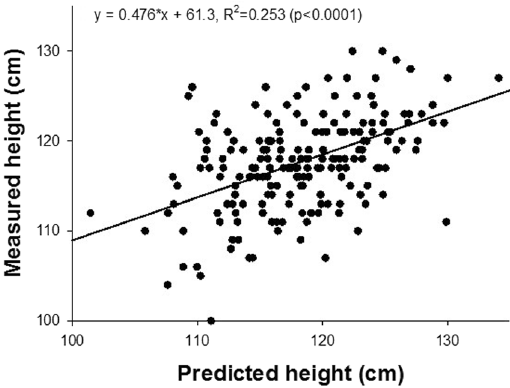
Figure 5. Measured height at 6 years of age as a function of predicted height computed from height at age of 1 month in 190 children from the BILD data